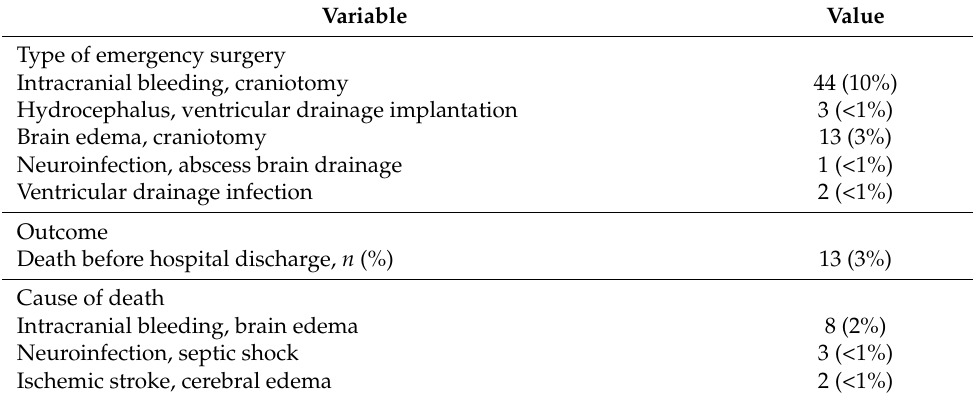
Table 1. Cont. Variable Value Type of emergency surgery